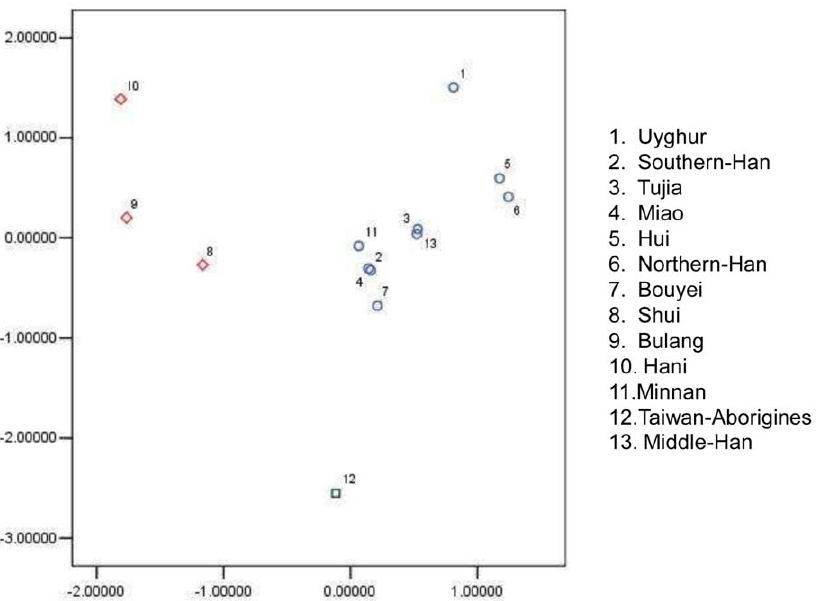
Figure 3. Result of Principal component analysis. Principal component analysis between Tujia population in Hubei with Chinese other 12 ethnic group based on the allelic frequencies of HLA-A loci.